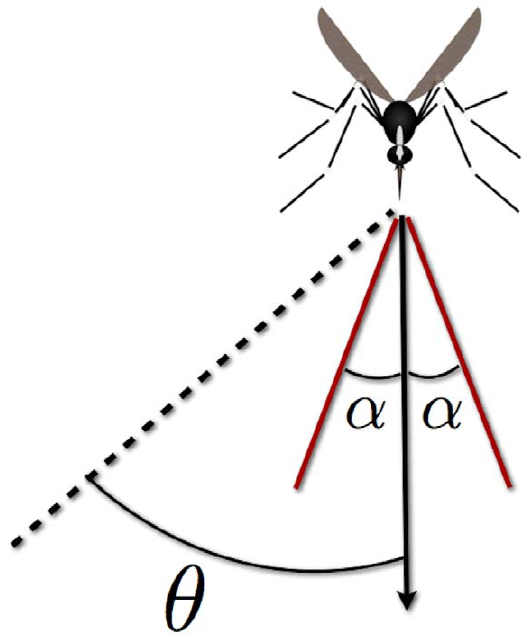
Figure 3. Mosquito flight direction choice. Schematic of the mosquito direction choice in the host-seeking model. At each discrete flight segment, the angle h represents the ideal target direction of the mosquito, which can only be sensed or followed to a precision of a